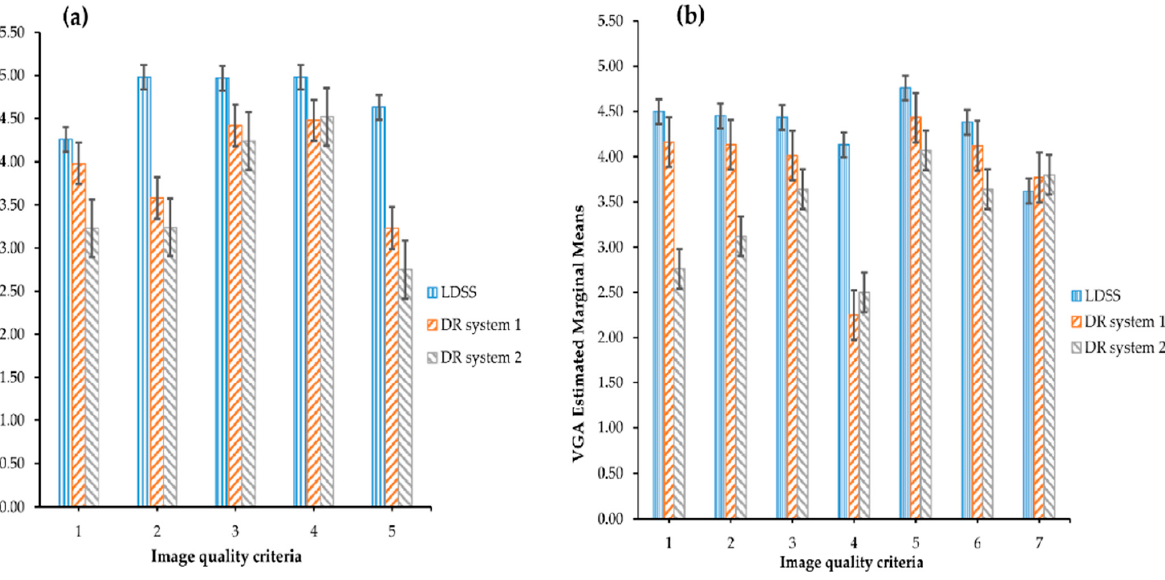
Figure 2. VGA estimated marginal mean comparison across the imaging systems and image quality criteria for ( a ) the chest PA projection and ( b ) the chest LAT projection.